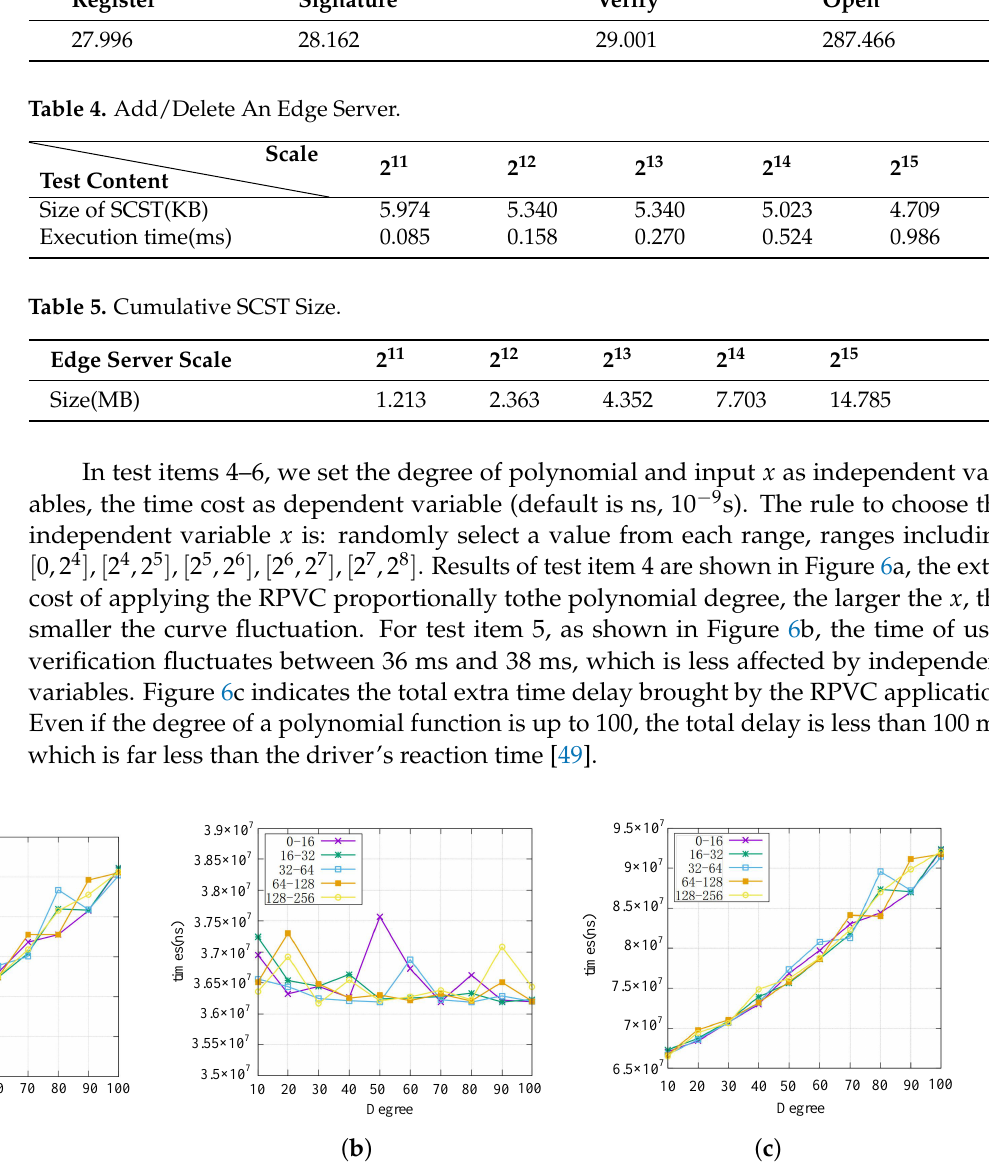
Figure 6. RPVC overhead. ( a ) Edge sever overhead. ( b ) User verify time. ( c ) Total